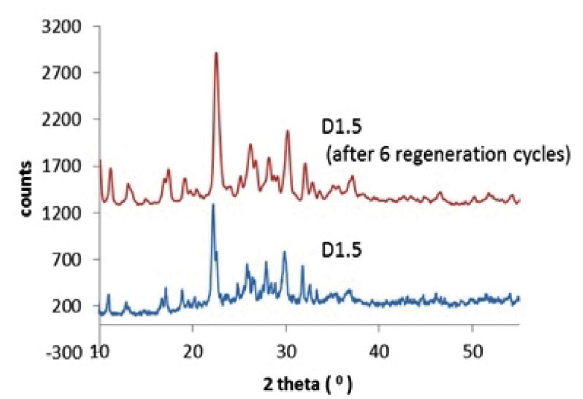
Fig. 12. The XRD spectra of the D1.5 sample before and after 6 regeneration